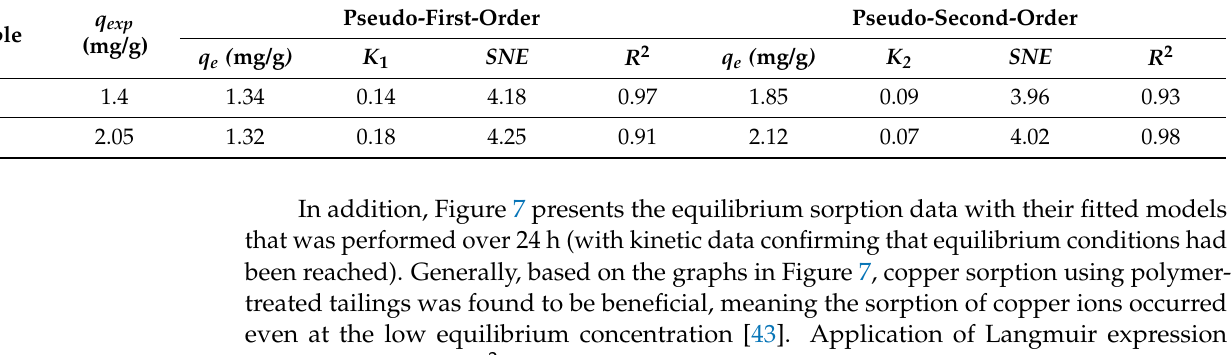
Table 2. Kinetic constants for the copper ions sorption of untreated and polymer-treated tailings. Pseudo-First-Order Pseudo-Second-Order Sample